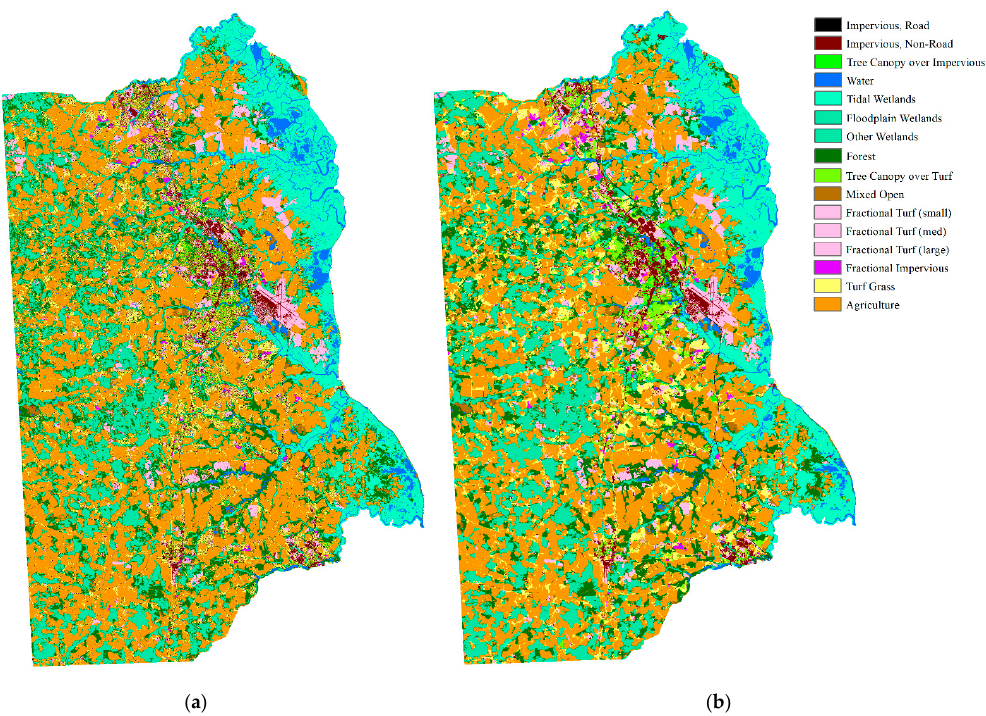
Figure 10. Comparison of 1 m land cover map and the overlaid segmentation map: ( a ) 1 m land cover map; ( b ) overlaid segmentation map.